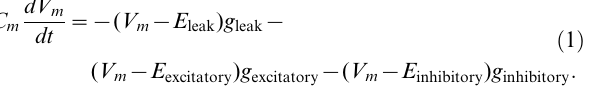
Table 1. Parameters used for model